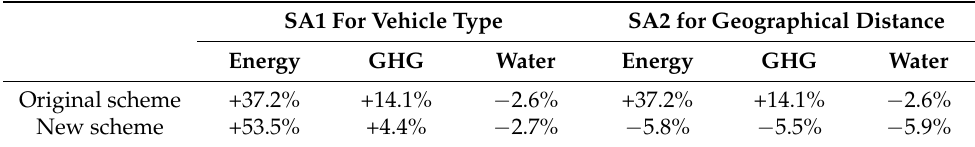
Table 1. The changing trend of the environmental impacts from Scenario 1 to Scenario 9.